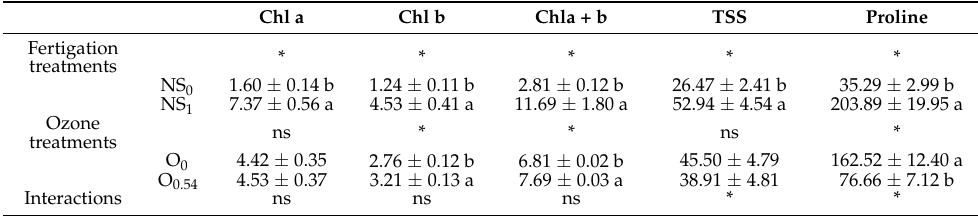
Table 7. Effect of fertigation and ozone on pigments concentration (chlorophyll a and b (Chl a and